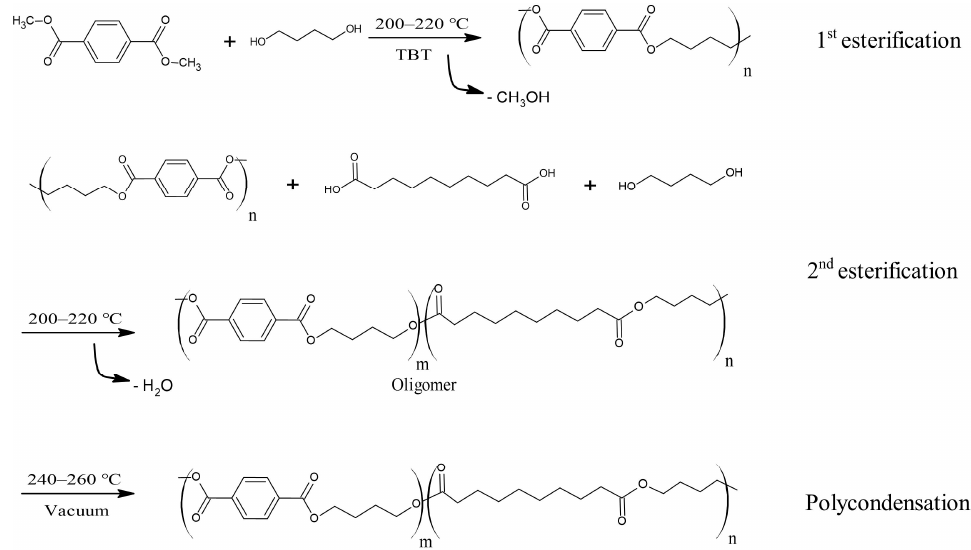
Figure 1. Schematic of PBSeT synthesis process.